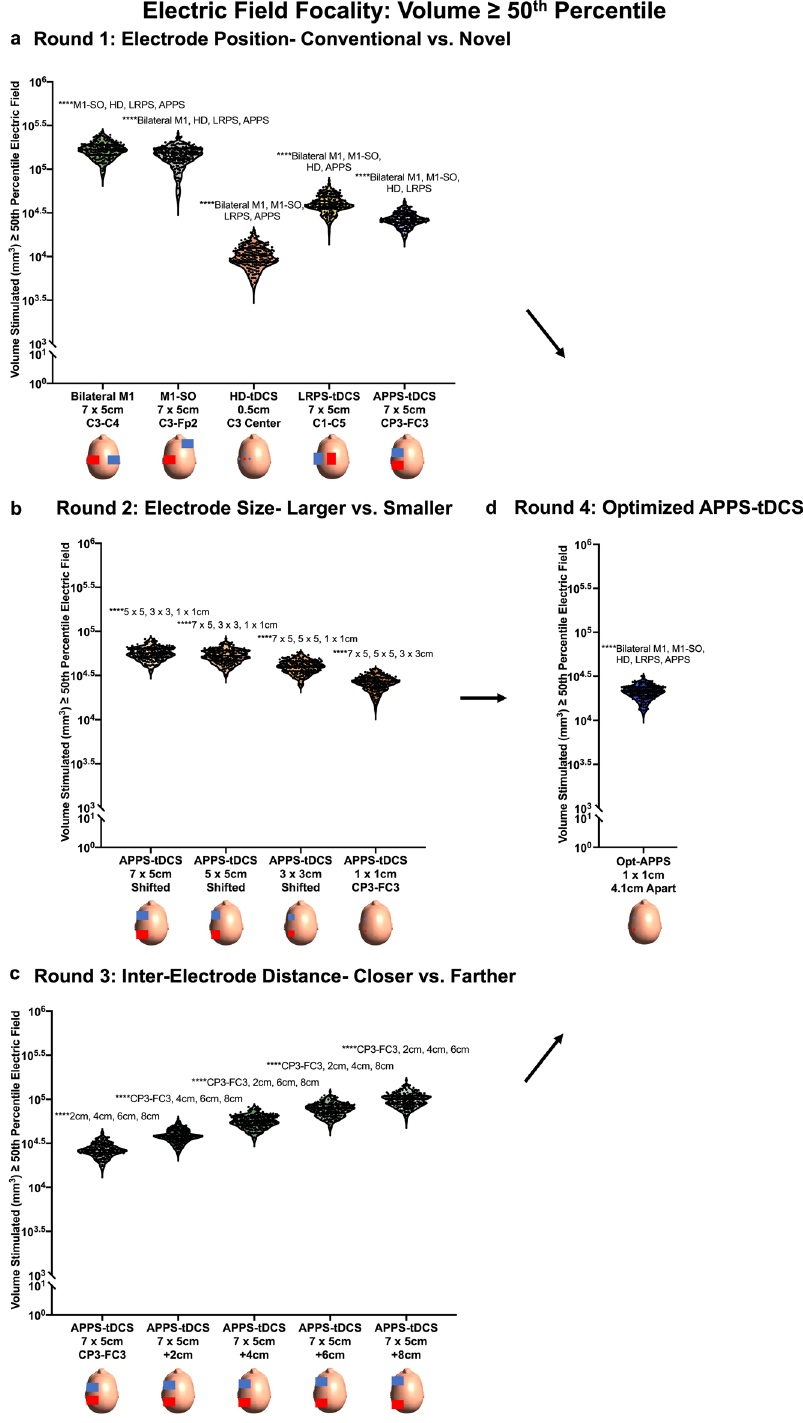
Figure 6. Electric Field Focality Results. In this figure, we analyzed the focality of stimulation as a function of the volume stimulated (mm 3 ) that was greater than or equal to the 50th percentile E-field. A higher volume stimulated represented less focal stimulation whereas lower volume stimulated represents more focal, on-target stimulation. Subfigures a-d represent Rounds 1–4 of E-field modeling respectively. Across all rounds of modeling, HD-tDCS was the most focal type of tDCS, stimulating a volume of only 1.07 × 10 4 mm 3 (SD = 2.93 × 10 3 mm 3 ). The second most focal stimulation type was optimized APPS-tDCS in Round 4 modeling, stimulating a volume of 2.14 × 10 4 mm 3 (SD = 3.73 × 10 3 mm 3 ). Round 2 modeling demonstrated that the smaller 1 × 1 cm electrodes stimulated the most focal volume, and Round 3 modeling showed that the volume stimulated linearly increased with the inter-electrode distance. See Table 2 for details. **** p < 0.0001 (Tukey